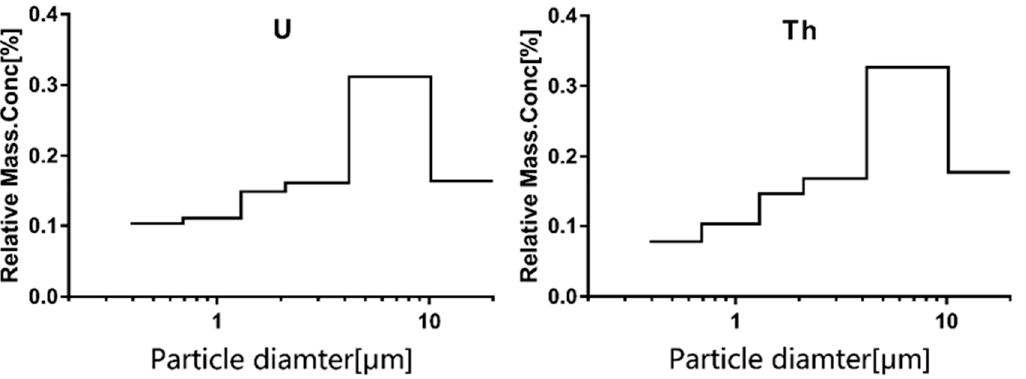
Figure 1. PM size distribution of uranium and thorium in atmosphere.